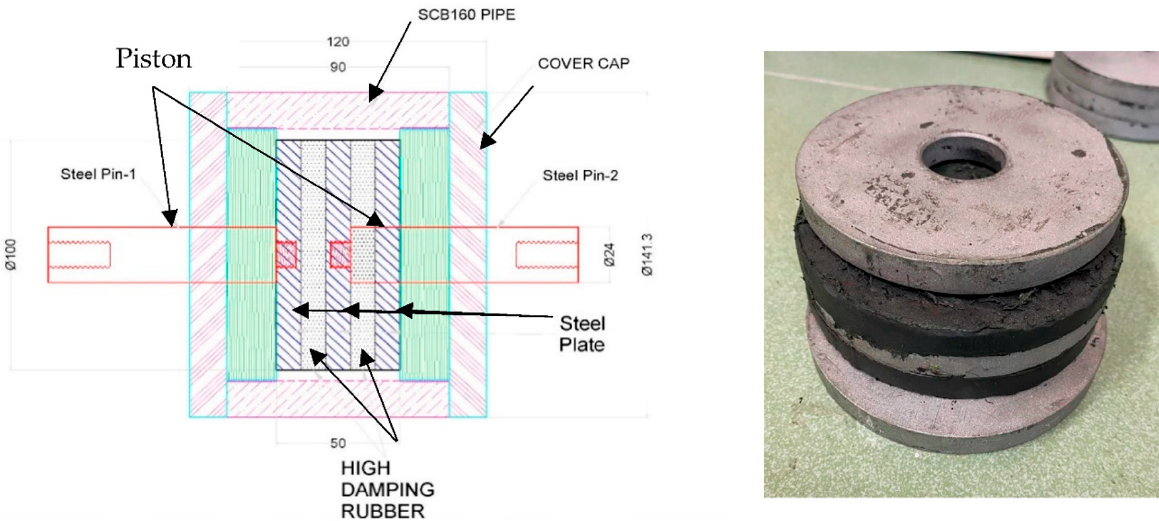
Figure 4. Typical isometric view and dimension of the proposed scaled-down hyperelastic composite